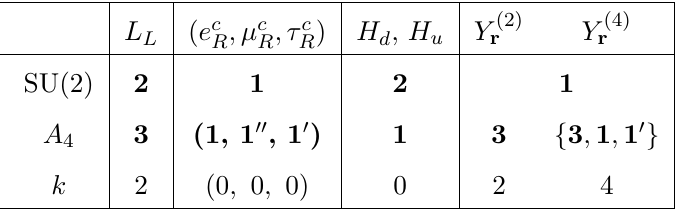
Table 3 . Representations and weights k for MSSM fields and modular forms of weight 2 and 4